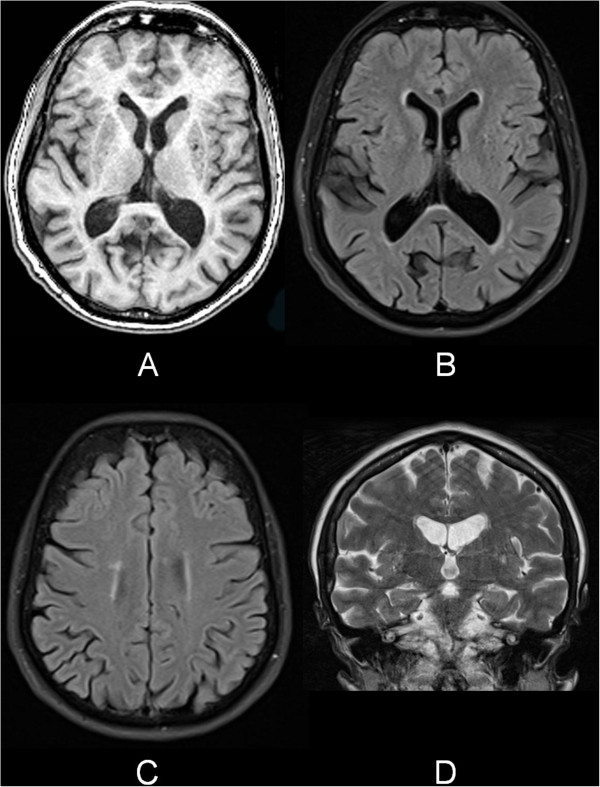
Magnetic resonance imaging scan of the brain. A, transverse T1-weighted image; B and C, transverse T2-weighted fluid attenuated inversion recovery image; D, coronal T2-weighted image of the medial temporal lobe and hippocampus. There was global cortical atrophy grade 1-2 with mild atrophy of the hippocampus (medial temporal lobe atrophy score, 1-2), on the left more pronounced than on the right. Compared to a magnetic resonance imaging scan performed one year earlier, there was no progression of these features. Furthermore, the T2-weighted images showed some punctuate subcortical hyperintensities but no other focal structural changes.